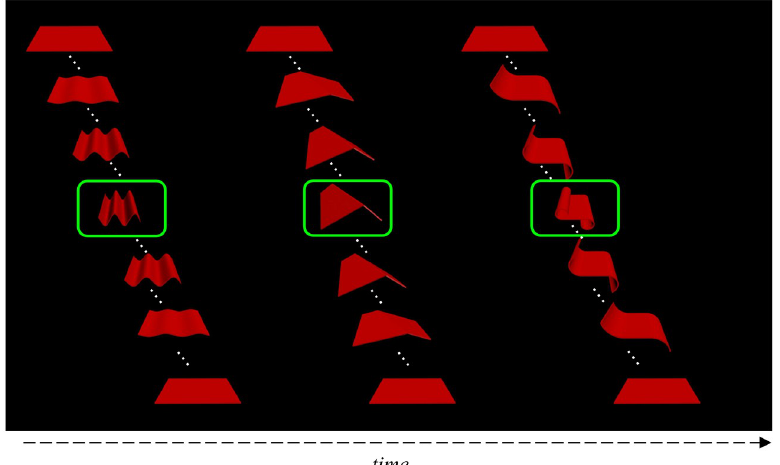
Fig 6. Example of an object transformation triplet from [41]. The images depict a sample of frames in a continuous video of an object—the red plane—transforming into each of three different target shapes, marked here with a green boundary, and back to its original form. In the video, the dynamic object was shown in the center of the display, whereas here the spatial arrangement from left to right depicts time. The duration of each transformation was the same; the figure does not depict the durations to scale. In one version of the experiment, the static images depicted in the boxes were displayed instead of its associated video clip.